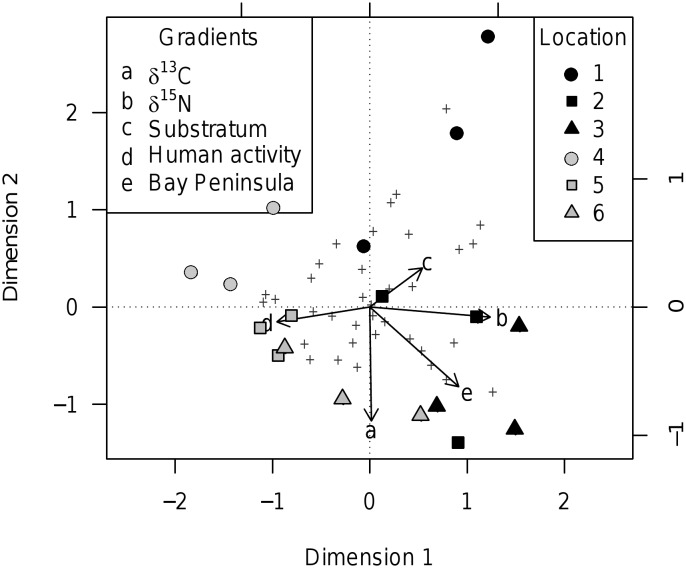
The distribution of sites (symbols) and macroalgal species (crosses) over environmental gradients (arrows), showing the separation of Antofagasta Bay from Mejillones Peninsula.A species-conditional triplot based on a canonical correspondence analysis, with P. purpuratus δ13C and δ15N included as environmental gradients. Eigenvalues of dimension 1 (horizontal) = 0.20 and dimension 2 (vertical) = 0.19; eigenvalue of the axis 3 (not displayed) = 0.09. Scale marks along the axes apply to the species and sites scores. Species crosses represent the weighted average of their ‘niche’ (by site), though labels were omitted to avoid cluttering the plot (listed in S2 Table). Rare species which occurred at <2 sites were removed a priori to analysis, as recommended by Bocard et al. [58]. Site symbols show Mejillones Peninsula (locations 2 & 3) and Bay (location 1) in black, and Antofagasta Bay (locations 4 & 5) and Coloso Point (location 6) in grey. 2D triplot displays 26.9% of total inertia (= weighted variance) in the observed occurrences and 65.3% of variance in the weighted averages and class totals of macroalgal species with respect to the environmental variables.